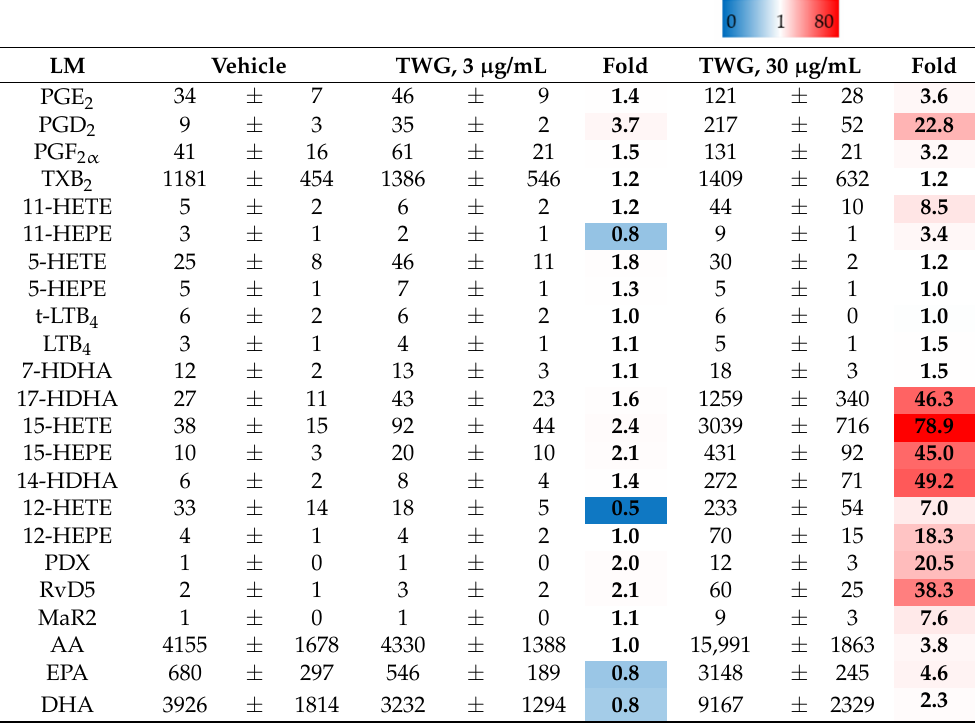
Table 2. Heatmap of LM produced by anti-inflammatory human M2-MDM and effects of TWG. M2-MDM were treated for 180 min with 3 or 30 µ g/mL TWG or 0.1% DMSO as vehicle. Then, formed LM released into the medium were extracted and analyzed by UPLC-MS/MS. Data are means ± S.E.M., n =